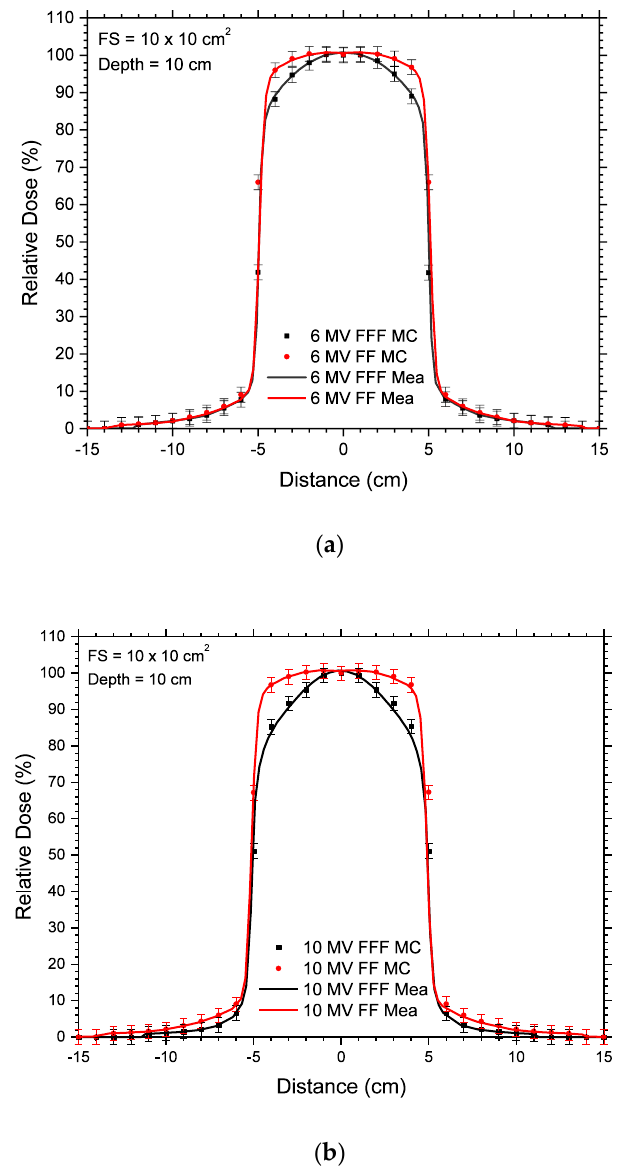
Figure 1. Off-axis profiles measured (Mea) and Monte Carlo simulated (MC) at a depth of 10 cm using the ( a ) 6 MV FF and 6 MV FFF; and ( b ) 10 MV FF and 10 MV FFF photon beams. The field size of the beam is equal to 10 × 10 cm 2 used in this